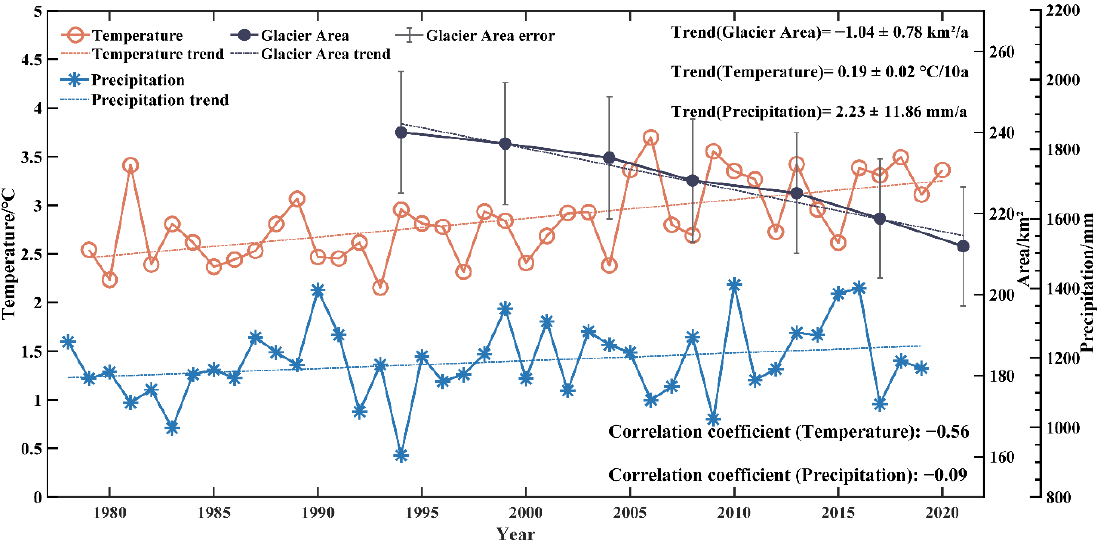
Figure 9. Changes in temperature and precipitation in the Gongga Mountains region from 1978–2020 and changes in glacier area from 1994–2021. Error bars of the glacier area (gray line) refer to the uncertainties shown in Table 5.